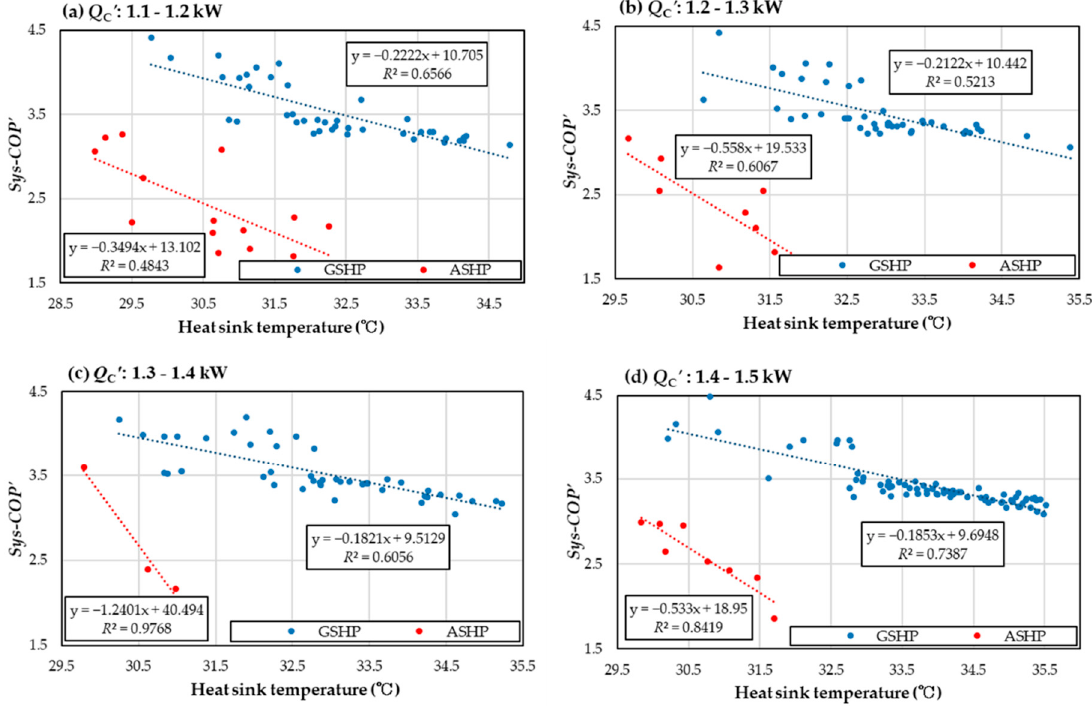
Figure 7. The relationship between the heat sink temperature and Sys-COP’ . When Q c ’ was in the range of ( a ) 1.1 to 1.2 kW; ( b ) 1.2 to 1.3 kW; ( c ) 1.3 to 1.4 kW; and ( d ) 1.4 to 1.5 kW.